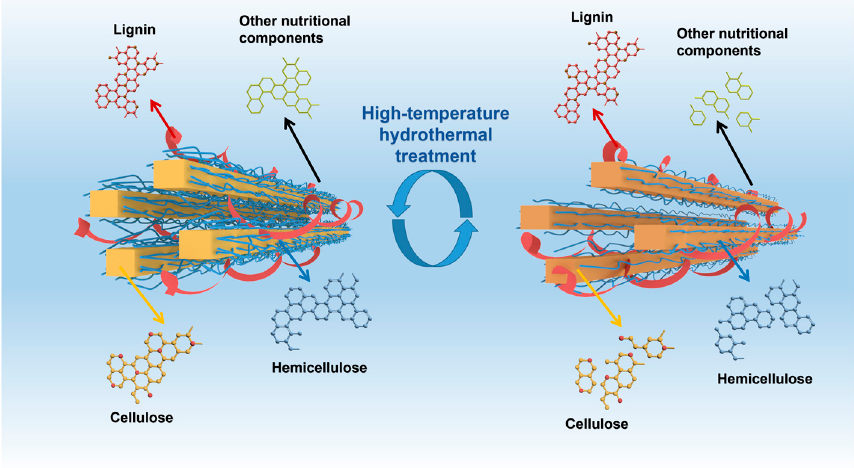
Figure 4. Schematic diagram of chemical composition changes of moso bamboo under high-temper- ature hydrothermal